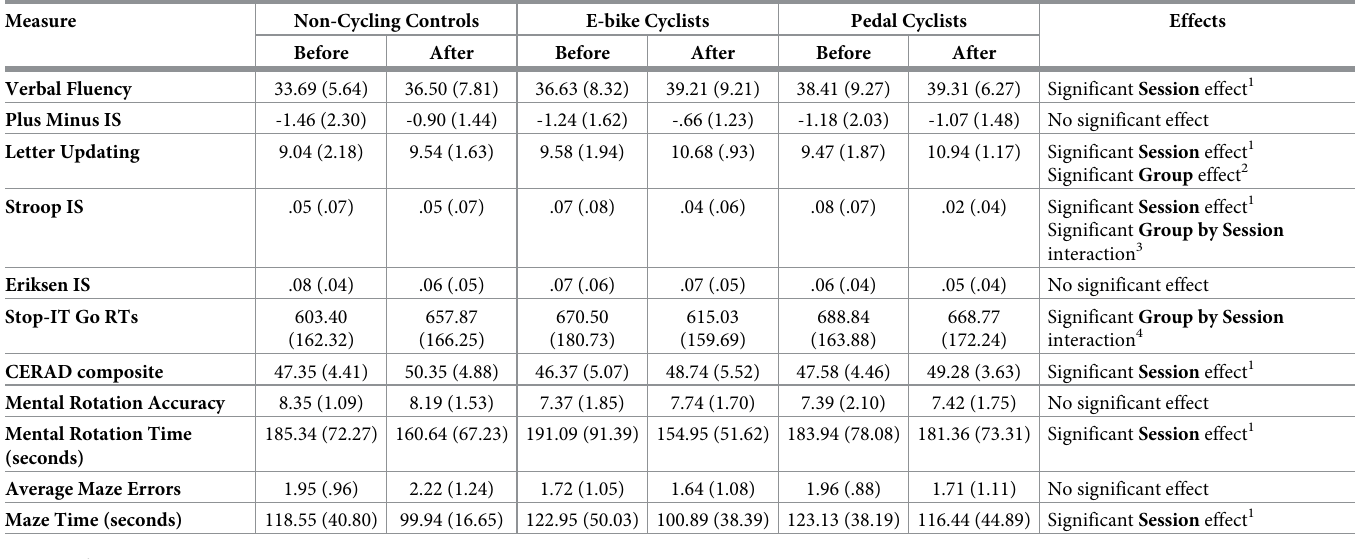
Table 4. Group (non-cycling controls, e-bike cyclists, pedal cyclists) means (SDs) for verbal fluency, plus-minus interference score (IS), letter updating, stroop IS, eriksen IS, stop-it, CERAD, mental rotation, maze completion before and after the intervention.